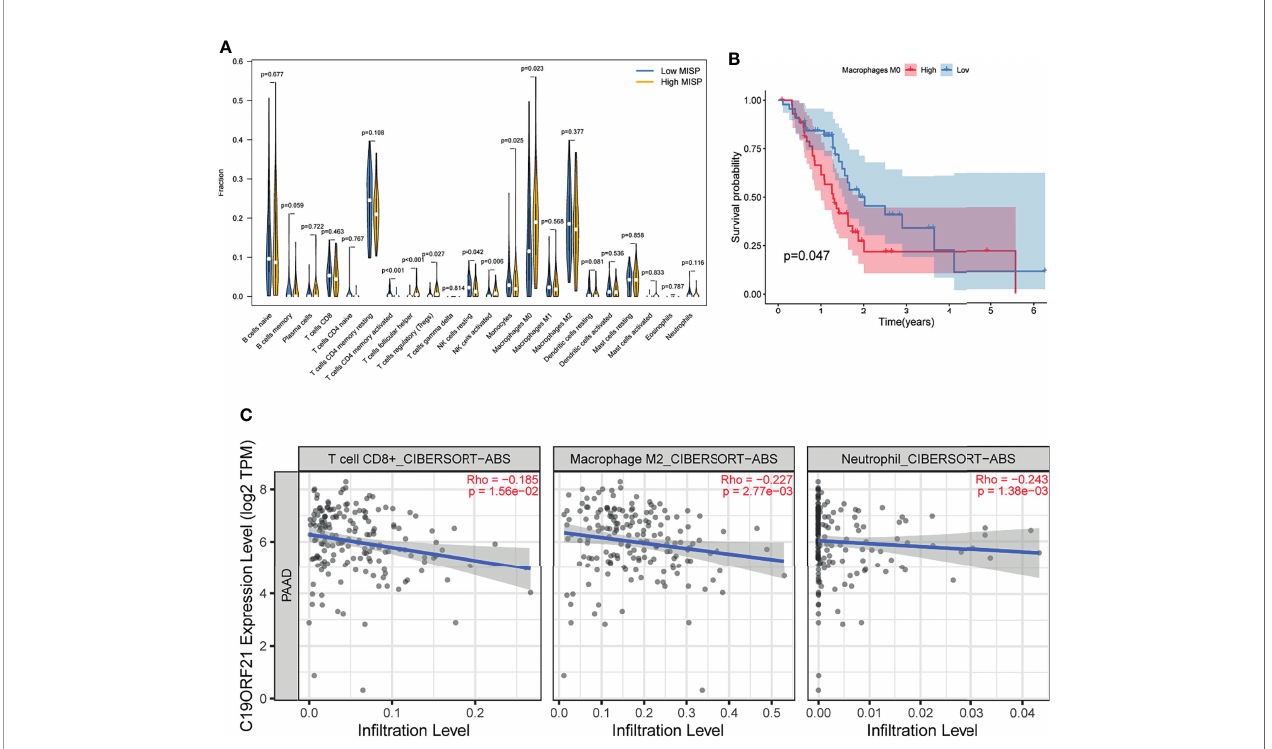
FIGURE 7 | Immune in fi ltration result. (A) Comparison of immune in fi ltration between high- and low- MISP subgroups. (B) Relationship between in fi ltration of M0 macrophage and survival rate in PDAC patients as analyzed by Kaplan-Meier. (C) Correlation analysis between the expression level of MISP and immune in fi ltration